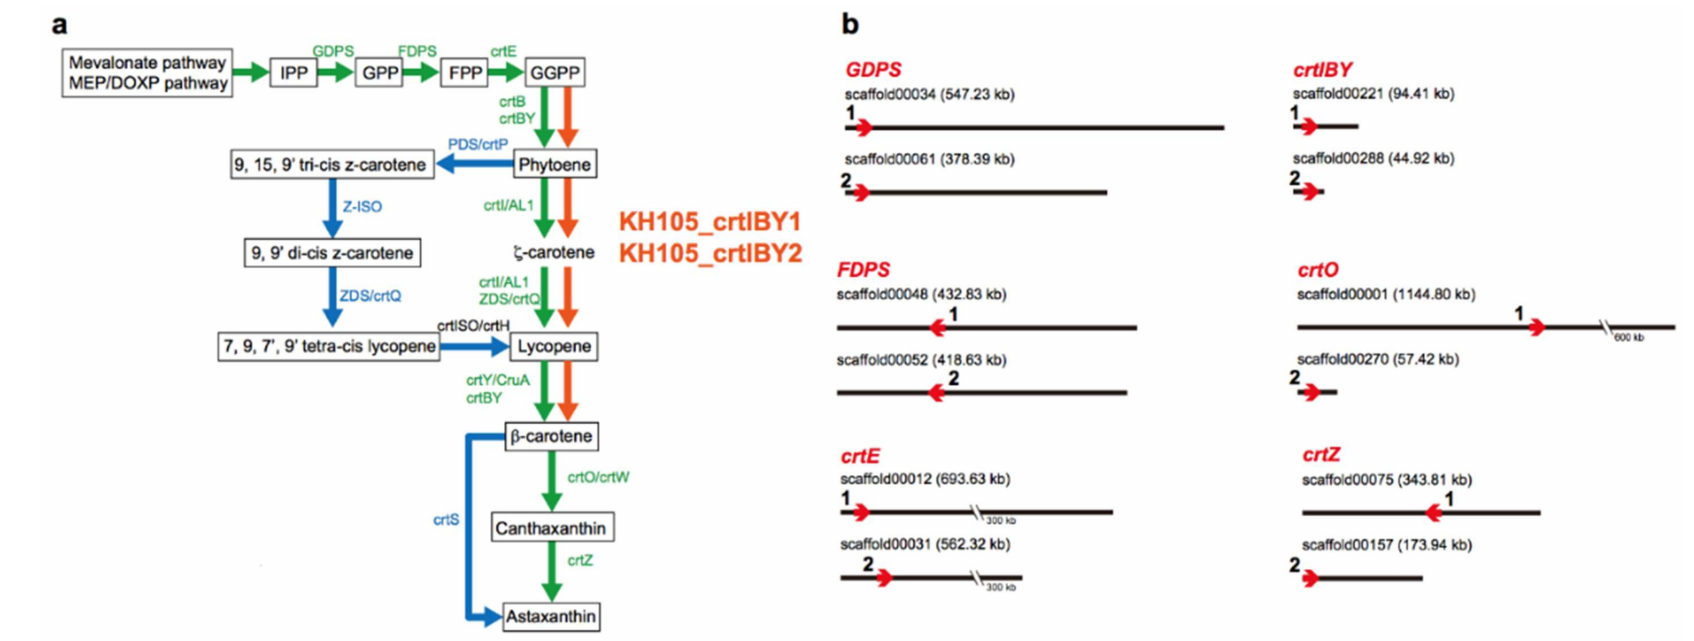
Figure 1. Genes encoding carotenoid biosynthetic enzymes of Aurantiochytrium sp. KH105. ( a ) The biosynthetic pathway for astaxanthin includes eight major enzymes, including geranyl diphosphate synthase (GDPS), farnesyl diphosphate synthase (FDPS), geranylgeranyl diphosphate synthase (CrtE), phytoene synthase (CrtB), phytoene desaturase (CrtI), lycopene cyclase (CrtY), β -carotene ketorase (CrtO), and β -carotene hydroxylase (CrtZ). Green lines indicate common pathways shared by many prokaryotes and eukaryotes, while blue lines indicate other pathways [40–48]. In the genome of Aurantiochytrium sp. KH105, three genes for crtB , crtI , and crtY are consecutively fused into a single, gene, crtIBY . The fused gene likely promotes the process from geranylgeranyl pyrophosphate (GGPP) to β -carotene; ( b ) Two copies of GDPS , FDPS , crtE , crtIBY , crtO, and crtZ were found in different scaffolds. The numbers and lengths (kb) of scaffolds are shown, and directions of the genes are indicated by